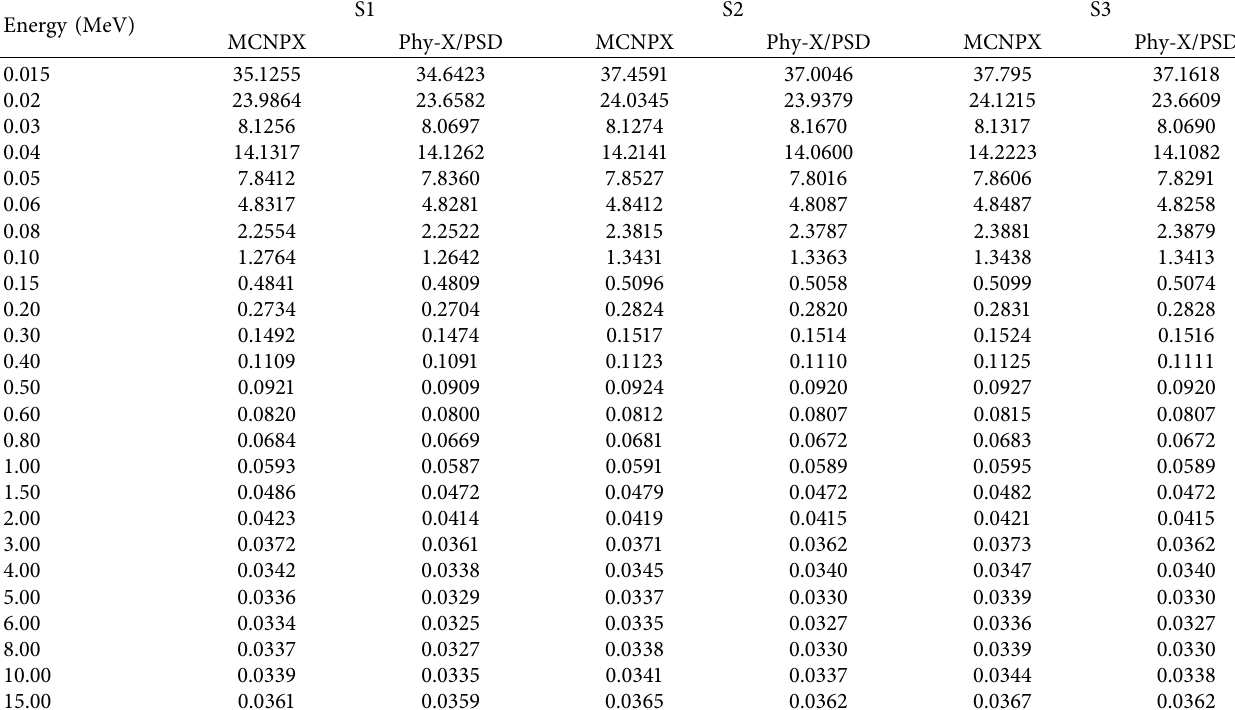
Table 2: Comparison of the mass attenuation coefficients obtained from MCNPX and